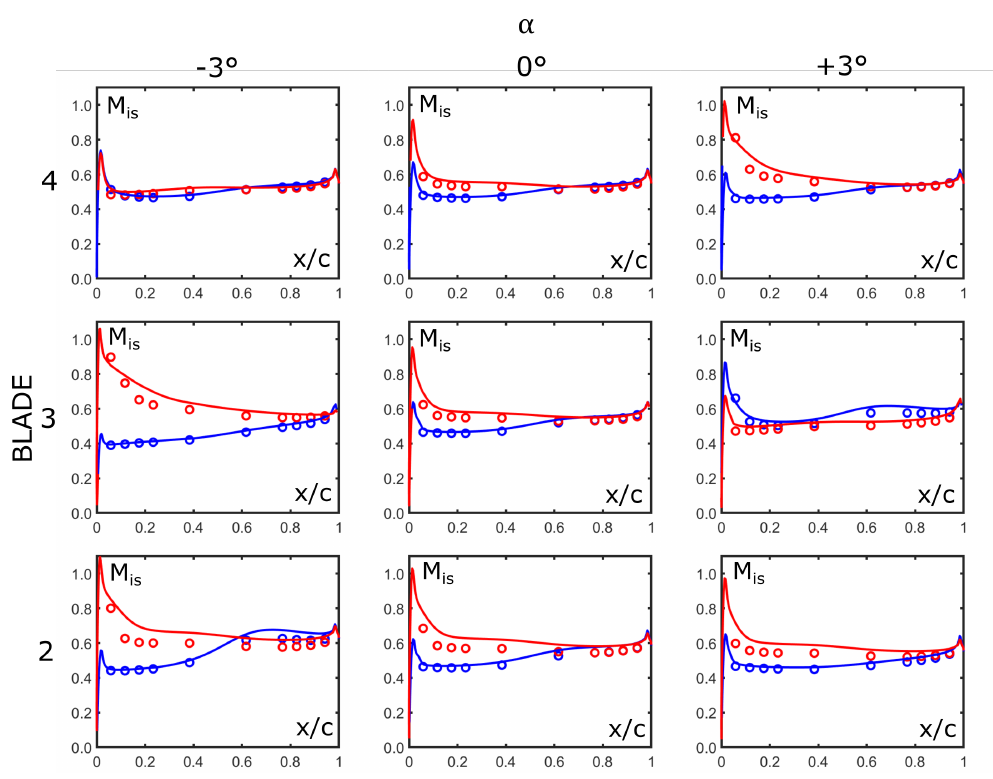
Figure 19. Isentropic Mach number distribution along blades 2, 3 and 4 at middle blade settings α = − 3°, 0° and 3°. Solid lines-CFD, symbols-EXP, red-lower surface, blue-upper